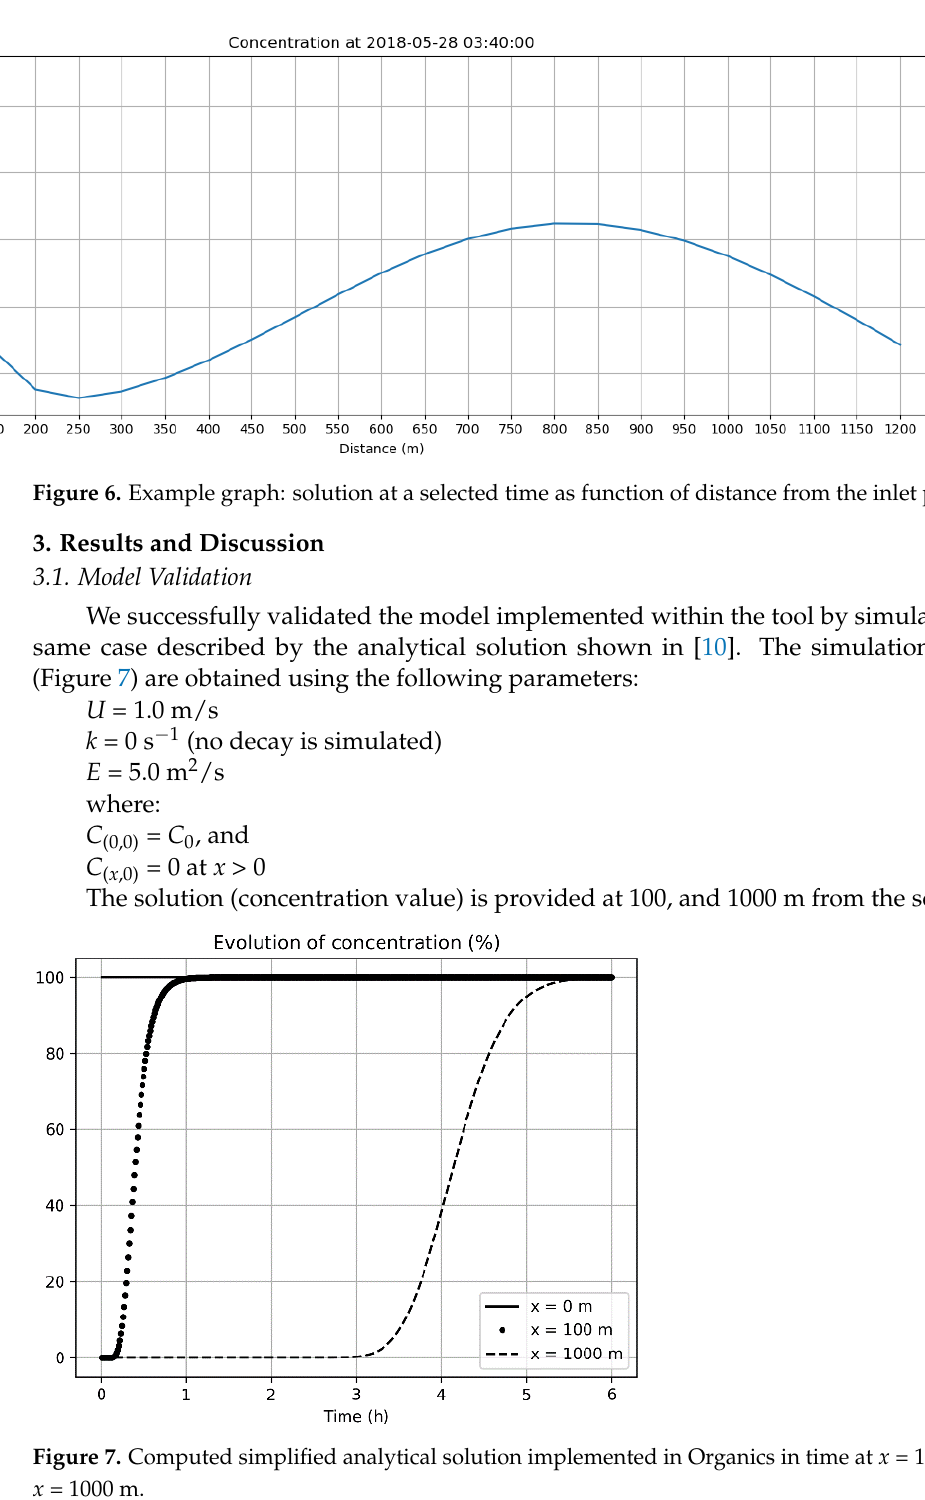
Figure 5. Example graph: solution at a selected points as function of time. Two points selected by